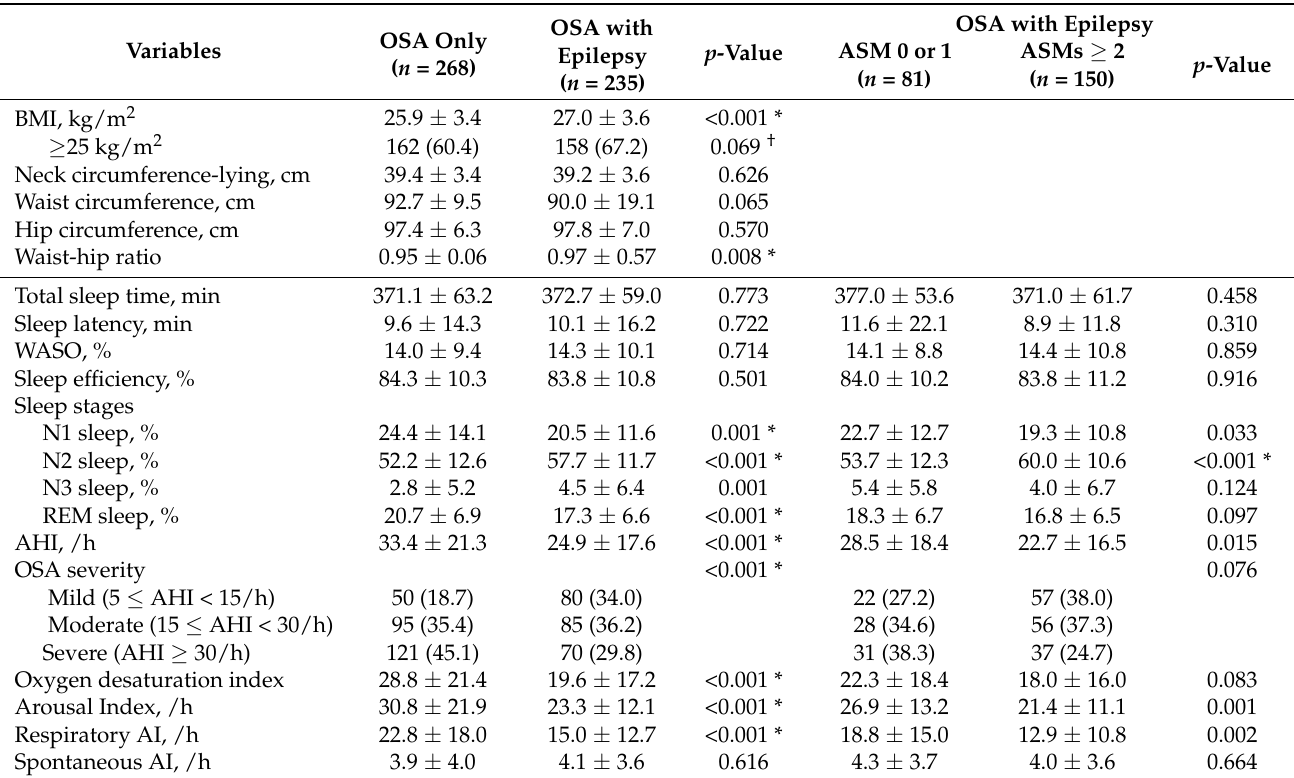
Table 3. Anthropometric and polysomnography